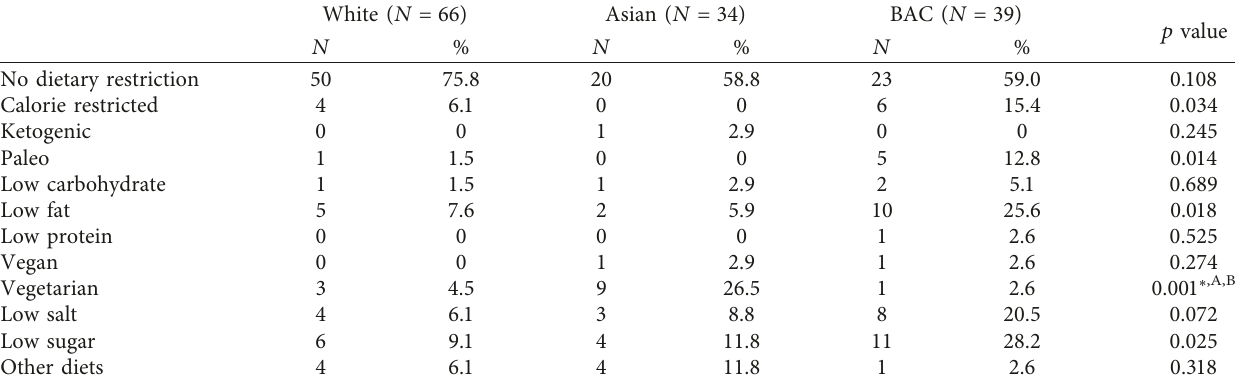
Table 2: Dietary habits including specific diets between the three different ethnic groups.